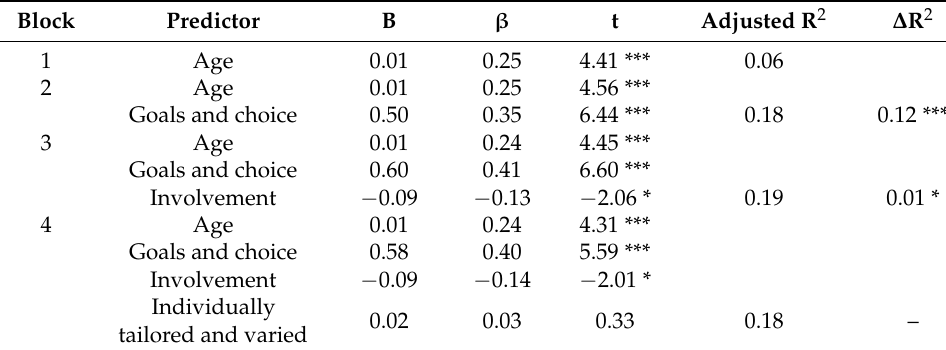
Table 2. Multiple block-wise regression analysis of positive challenges at work.